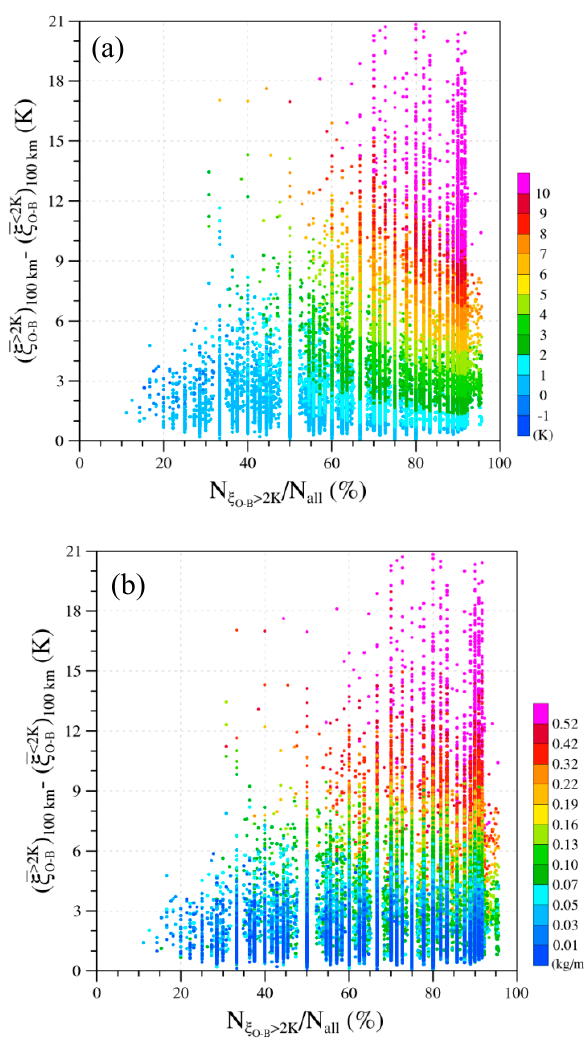
N ξ O − B > 2 K N all ξ − within the relevant O B